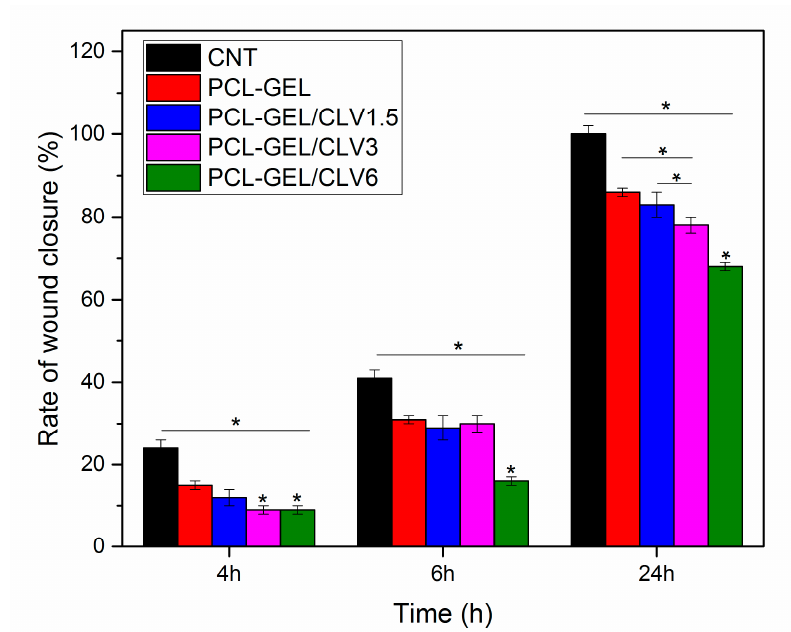
Figure 8. In vitro wound healing assay in the presence of CNT, PCL-GEL, PCL-GEL / CLV1.5, PCL-GEL / CLV3, and PCL-GEL / CLV6 in 24 h ( n = 3, samples in triplicate, * p < 0.05).